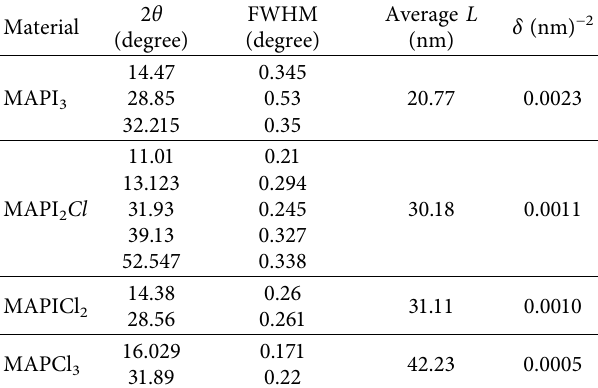
Table 2: XRD peak positions, FWHM, average L , and δ of the prepared